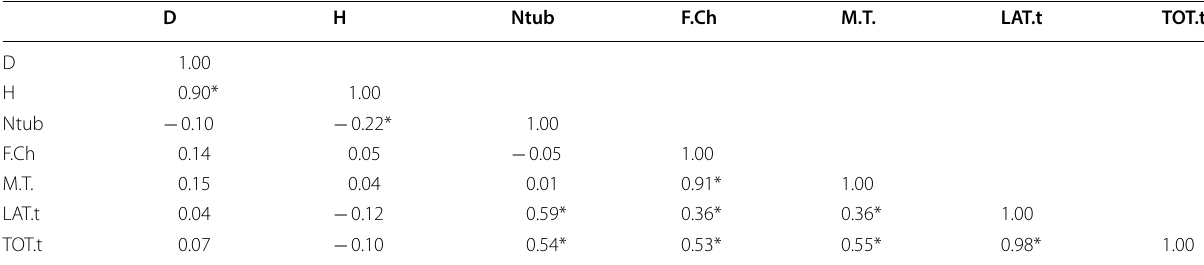
Table 2 Coefficients of correlation between shell size traits and spermathecal traits of Helix lucorum